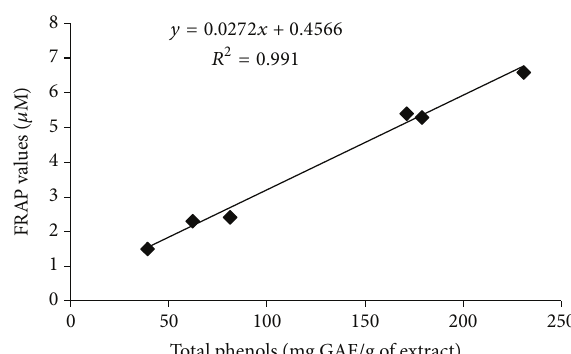
Figure 12: Correlation between total phenols and FRAP of seed extracts of Loranthus pulverulentus